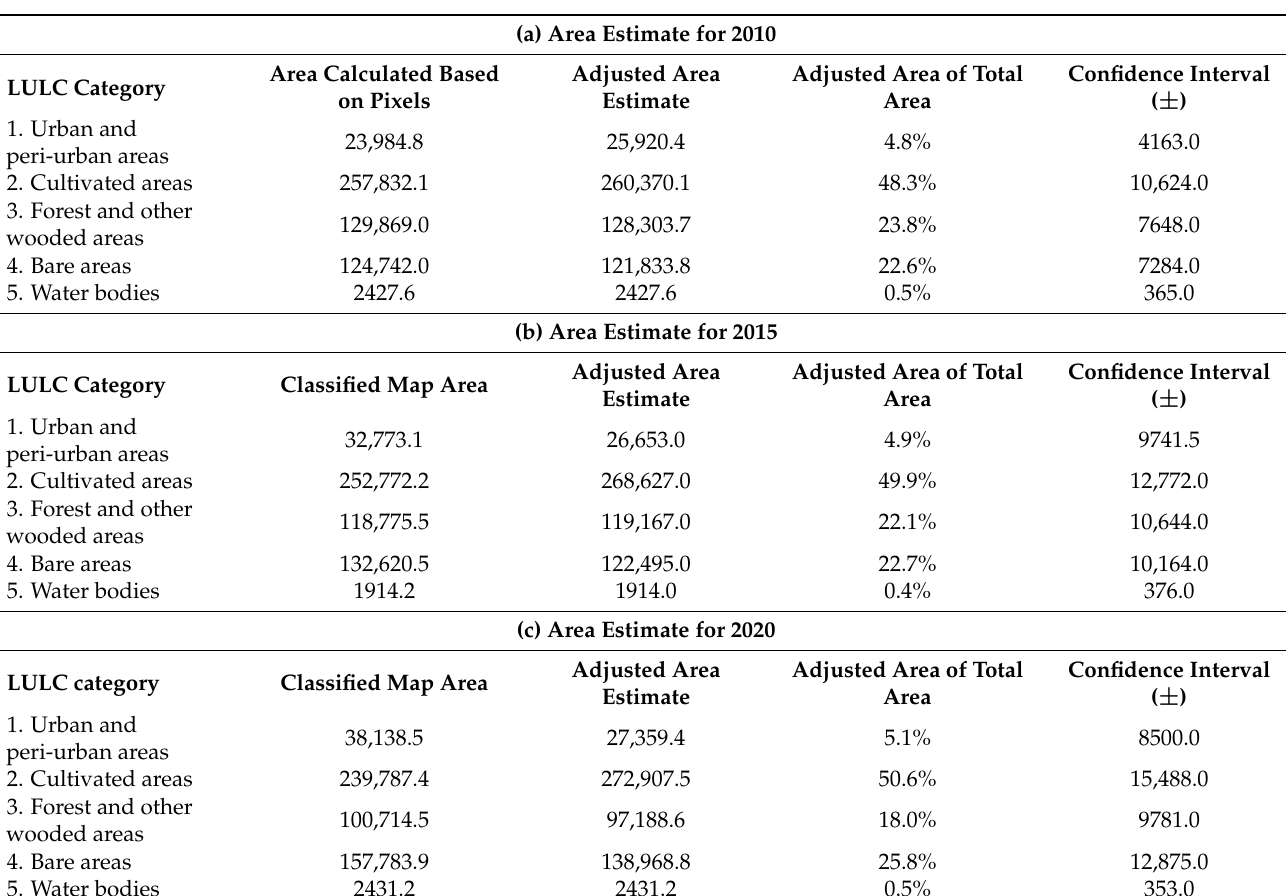
Table 6. Area estimates in hectares (ha) and percentage share (%) of each LULC category between 2010 and 2020 (after computing adjusted area estimate).